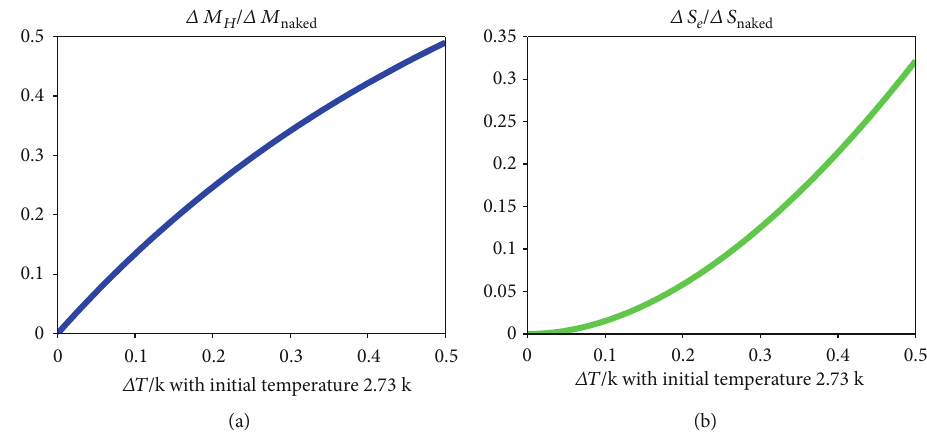
Figure 7: (a) and (b) show Δ M